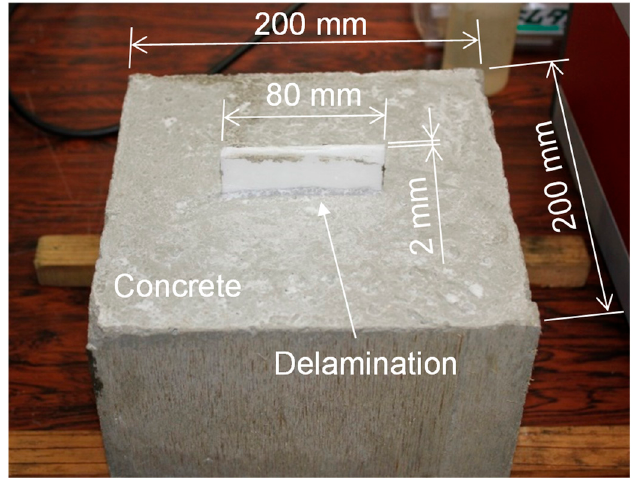
Figure 8. Concrete specimen with a delamination simulated with a Styrofoam plate (2 mm thickness, 80 mm